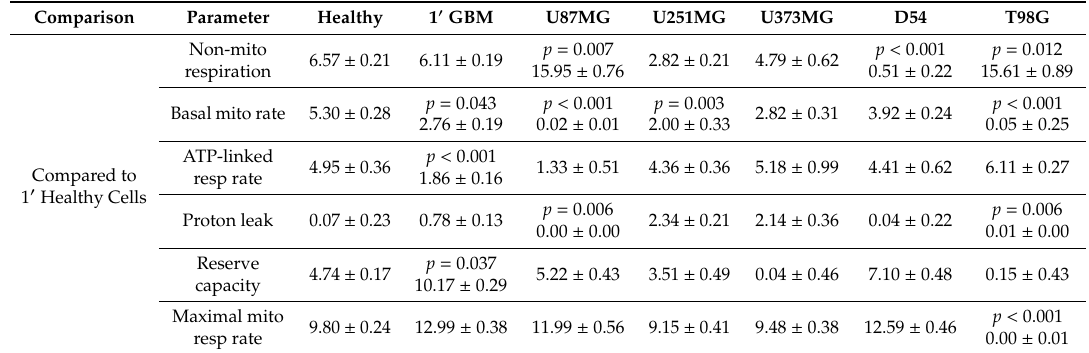
Figure 2. Mitochondrial respiration rate in primary healthy and GBM cells, and GBM cell lines. Cell populations of ( A ) primary mixed neural cells, ( B ) primary GBM cells, ( C ) U87MG, ( D ) U251MG, ( E ) U373MG, ( F ) D54 and ( G ) T98G cells were isolated and mitochondrial metabolic activity was measured as changes in OCR. Data presented represent the mean, with quartile 1 and 3 marked. For all data points in cell lines, n = 5; in primary healthy cells, n = 8; in primary GBM cells, n = 13; plated in triplicate. * above error bars show a statistically significant comparison between baseline control and treatment group. * p ≤ 0.05, ** p ≤ 0.01, and *** p ≤ 0.001. Table 1. Values of significance for cell comparisons of OCR-related metabolic